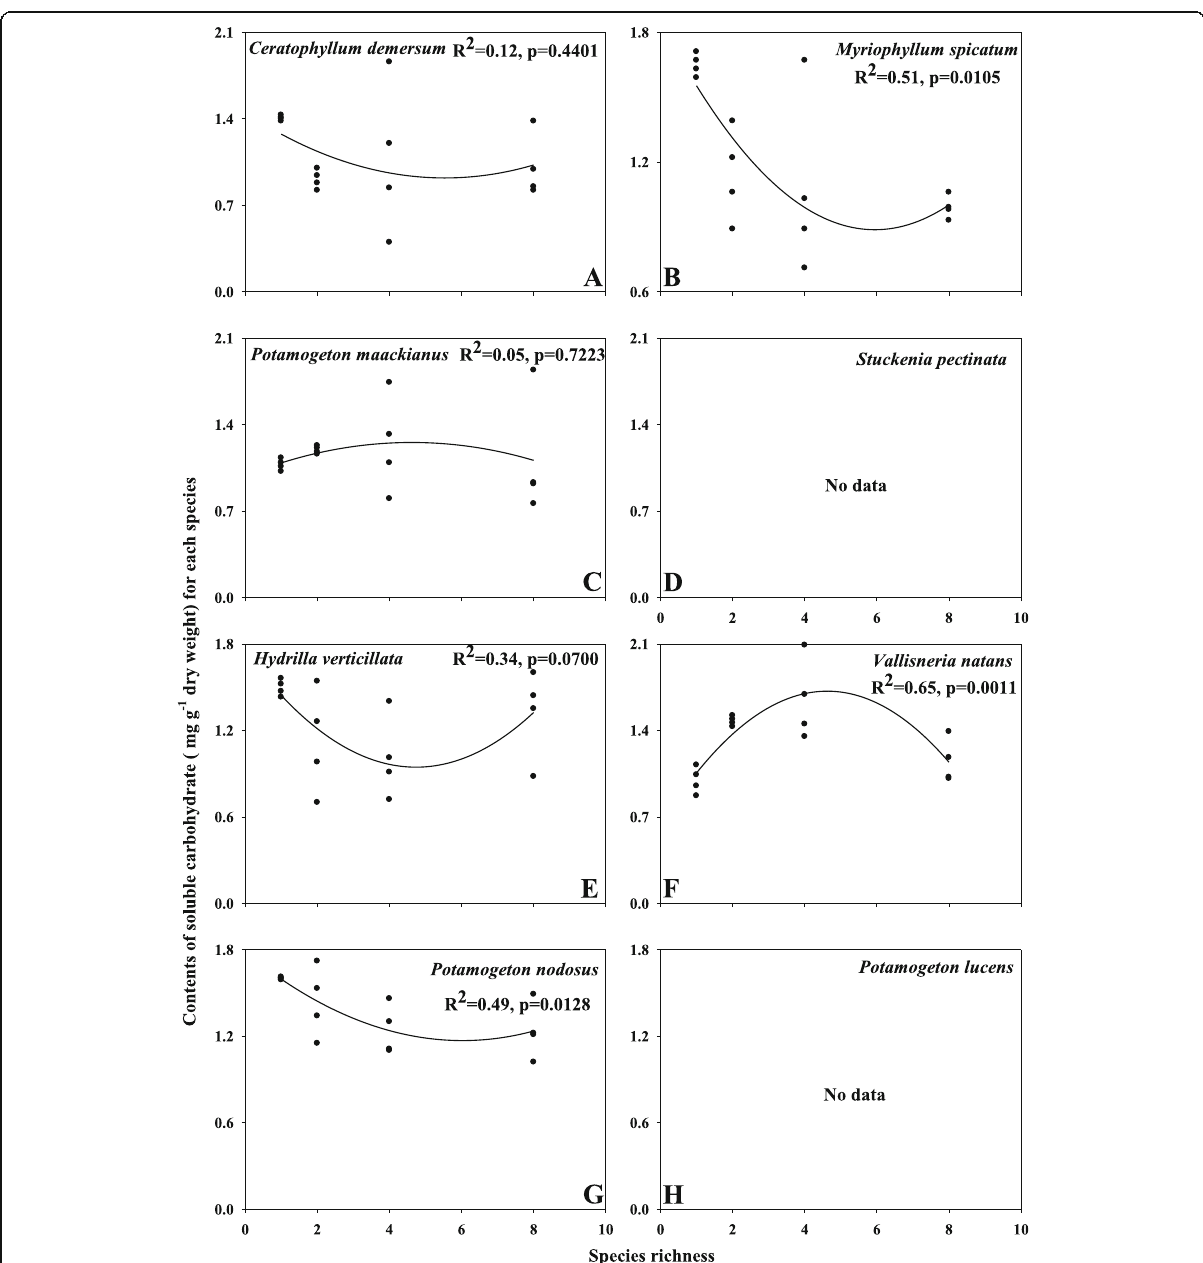
Fig. 5 The plant soluble carbohydrate of individual species along an aquatic plant biodiversity gradient in Lake